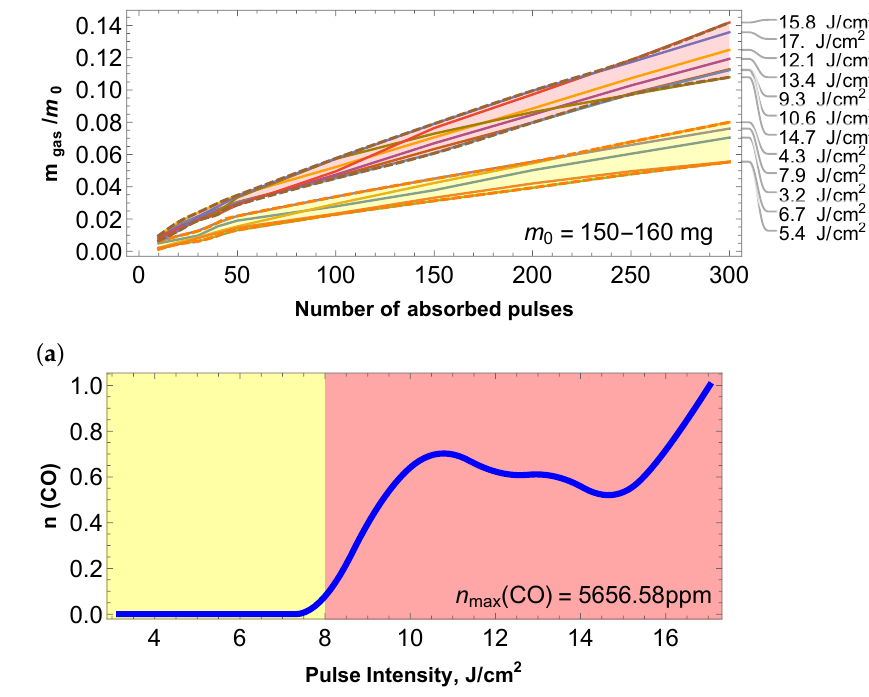
Figure 3. The dynamics of production of the finely atomized fuel under the effect of the laser pulses for different intensities ( a ). The dependence of the CO (main combustible component of the syngas) production efficiency ( b ) on the pulse intensity. The background in ( b ) shows the light intensity ranges below the threshold of an effective CO production (yellow) and above it